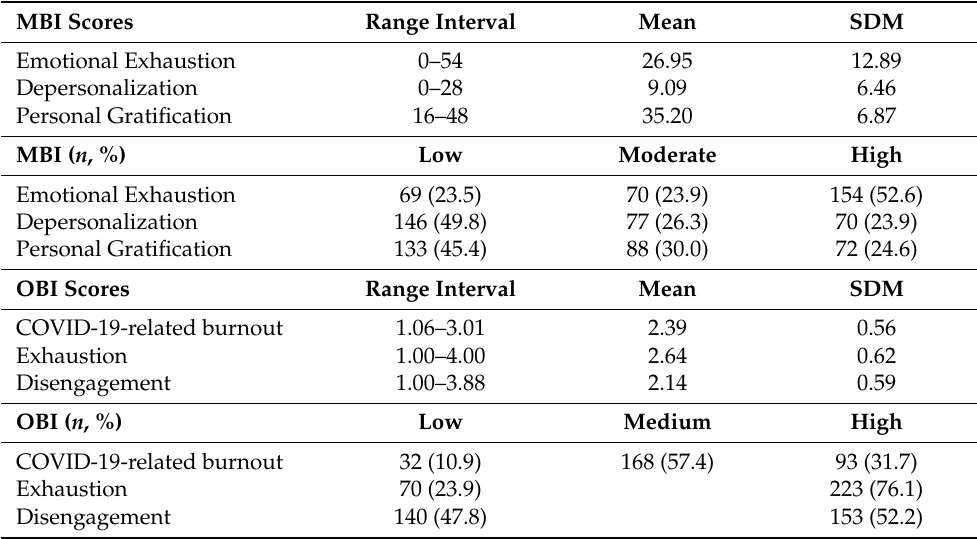
Table 3. Results from the Maslach Burnout Inventory (MBI) and the Oldenburg Burnout Inven- tory (OBI).